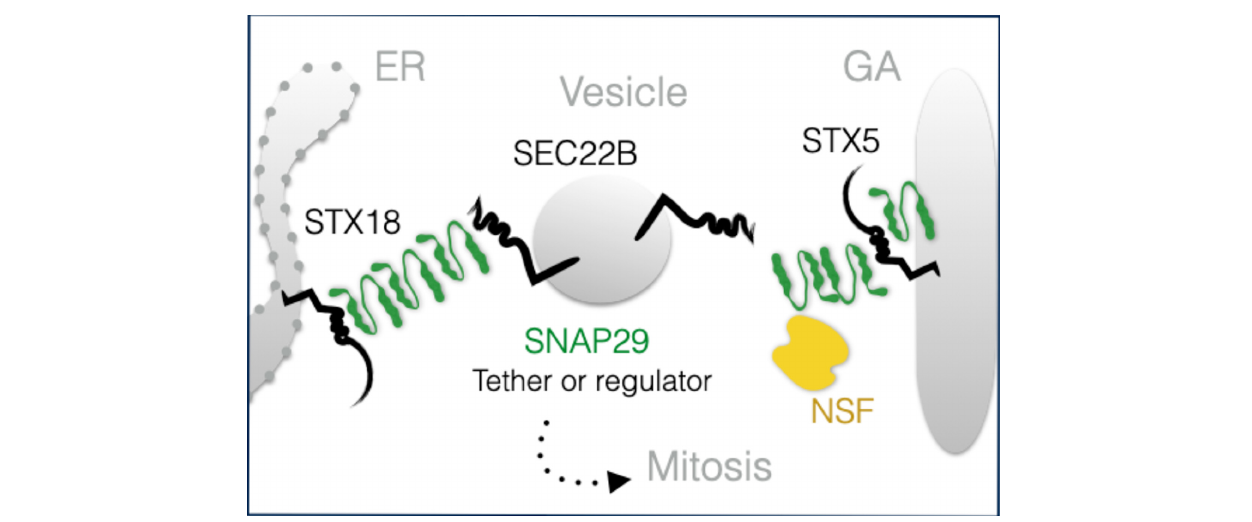
FIGURE 7 | A model of SNAP29 activity at the endoplasmic reticulum (ER) and Golgi apparatus (GA). SNAP29 forms elongated structures that could assist the tethering of vesicles and/or that could regulate STX5/18 fusion competence. Some of SNAP29 are re-localized from the ER–GA area to form the outer kinetochore of mitotic chromosomes in